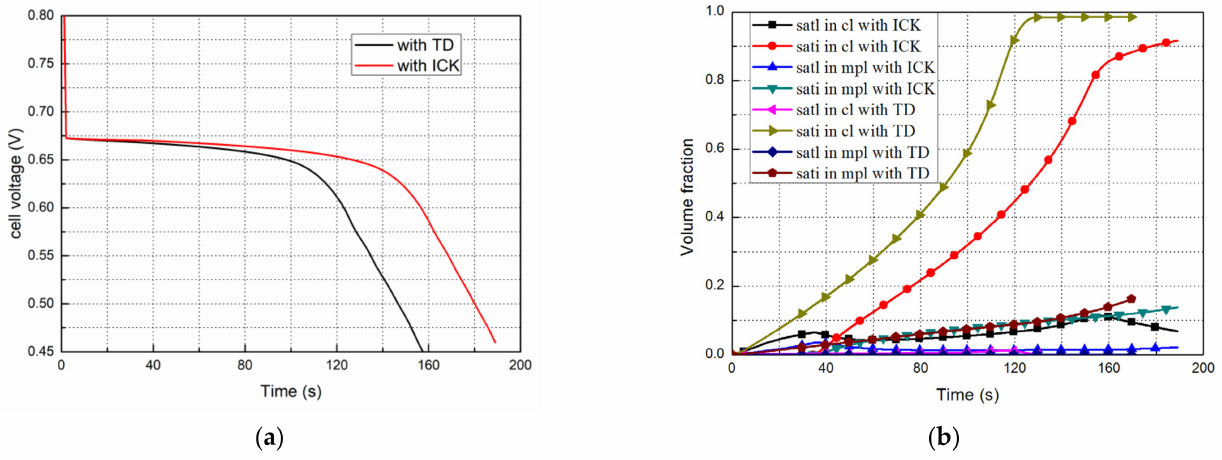
Figure 5. Evolution of the performances, and the liquid and ice saturations in the cathode CL and MPL when started from − 20 ◦ C at 0.08 A/cm 2 under ICK and TD. ( a ) Performance evolution; ( b ) Liquid and ice saturation